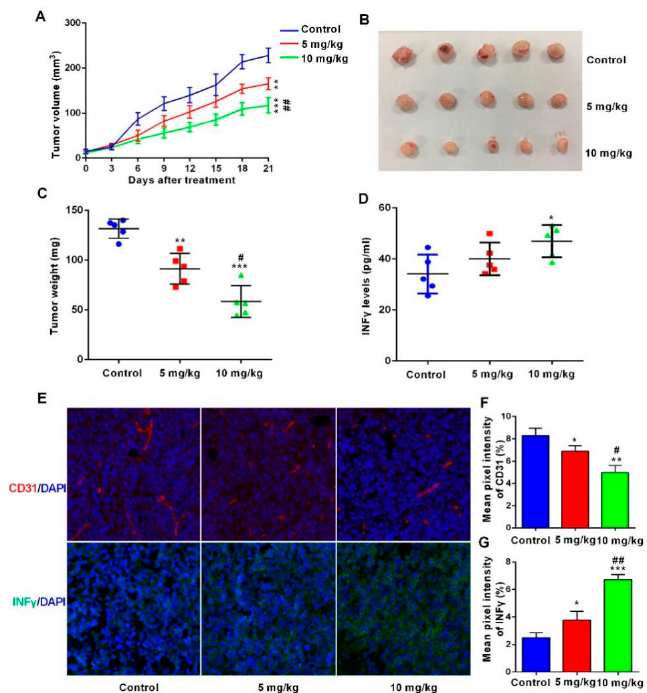
Figure 10. BsDb suppressed tumor growth in vivo. ( A ) The tumor volume of xenograft mice during the treatment. BsDb exerted robust antitumor activity in vivo with a dose-dependent manner. ( B , C ) mice were sacrificed after treatment for 21 days and tumors were collected and weighed. ( D ) Serum levels of INF- γ in different groups of mice were detected using ELISA after treatment for 21 days. Data were expressed as the mean ± SD ( n = 5). ( E ) Immunofluorescence staining of CD31 (red fluorescence) and INF- γ (green fluorescence) in sections from tumors of different groups of mice. The cell nuclei were stained with 4',6-diamidino-2-phenylindole (DAPI) in blue and the sections were photographed using a fluorescence microscope (200×); ( F , G ) quantitative analysis of CD31 and INF- γ fluorescence staining using ImageJ software. Data were expressed as the mean ± SD ( n = 3). Statistical analysis was tested using one-way analysis variance (ANOVA) and post hoc Tukey honestly significant difference (HSD). * p < 0.05, ** p < 0.01, and *** p < 0.001 versus the control group; # p < 0.05 and ## p < 0.01 versus the 5 mg/kg group.